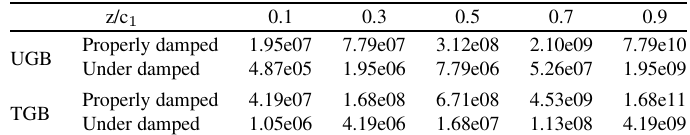
Table 2 Values of damping for bearings in the simulation (Nm − 1 s)